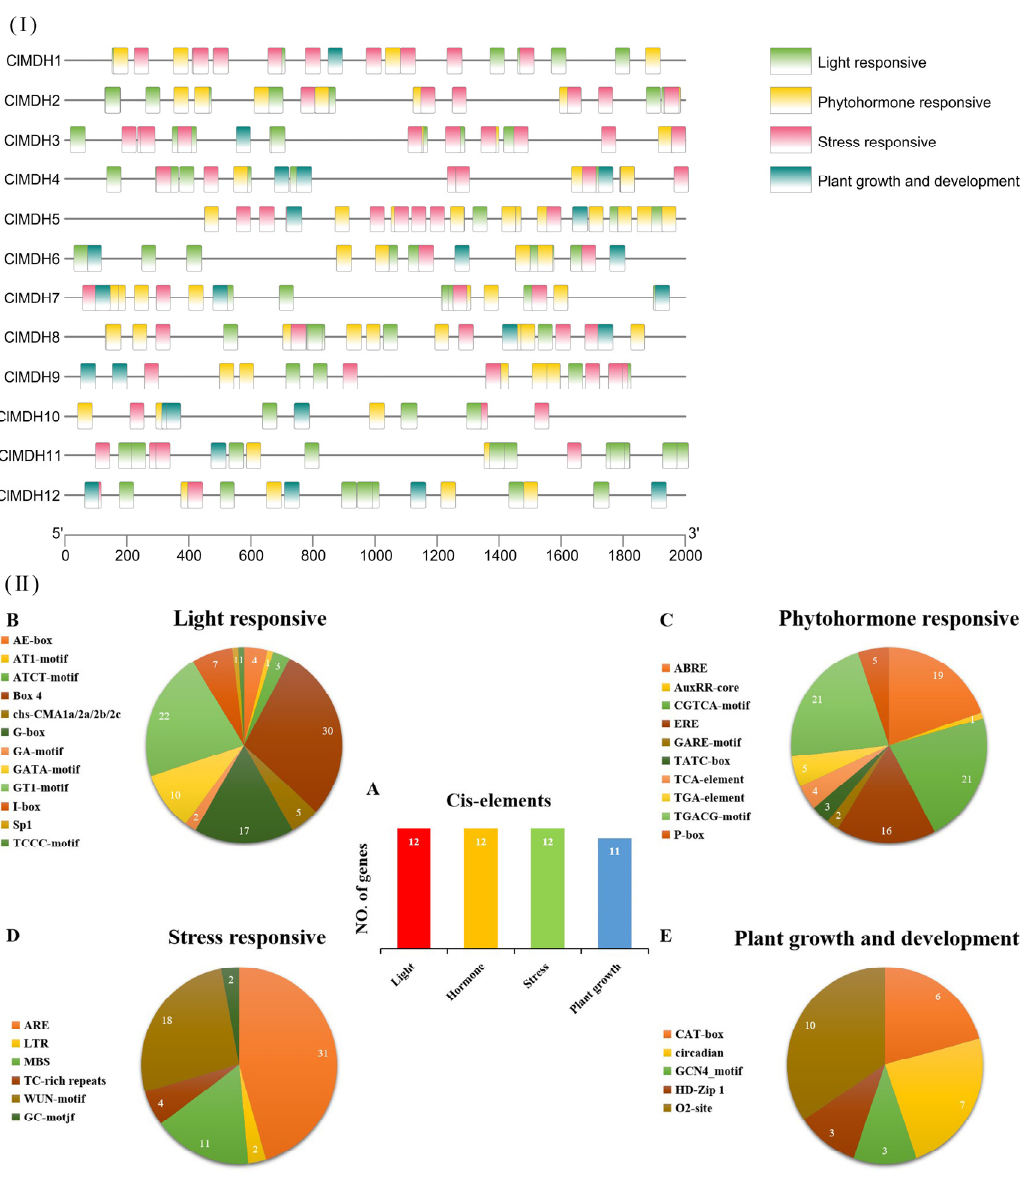
Figure 4. The cis -elements analysis of ClMDH genes ( Ⅰ , Ⅱ ). ( A ) the sum number of ClMDH genes involved in four categories of cis-elements from each category is presented in pie charts; ( B ) light responsive; ( C ) phytohormone responsive; ( D ) stress responsive; and ( E ) plant growth and development. Different colors indicate different cis -elements and their ratios present in ClMDH genes.